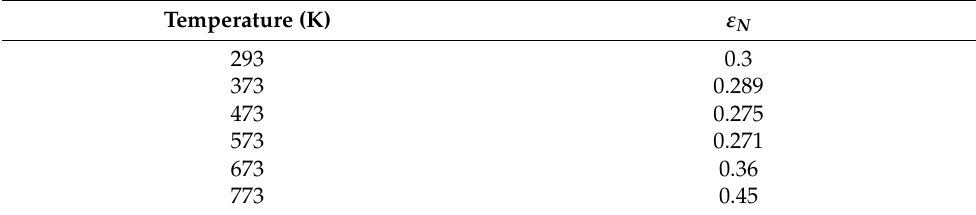
Table 3. Values of ε N at different temperatures.